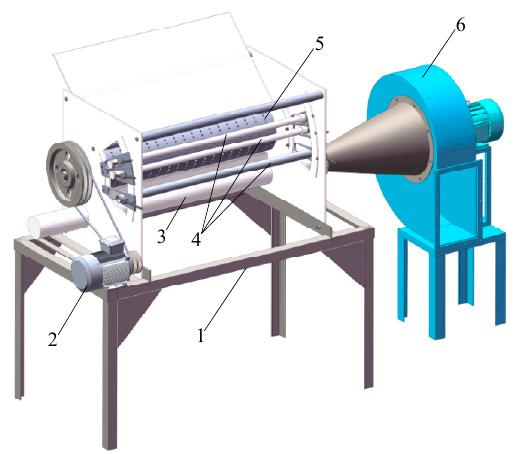
Figure 1. Schematic diagram of the needle roller-type residual film electrostatic separation device. 1. Frame; 2. Motor; 3. Negative pressure suction pipe; 4. Corona electrode and electrostatic electrode; 5. Grounding roller; 6. Dust exhaust fan.